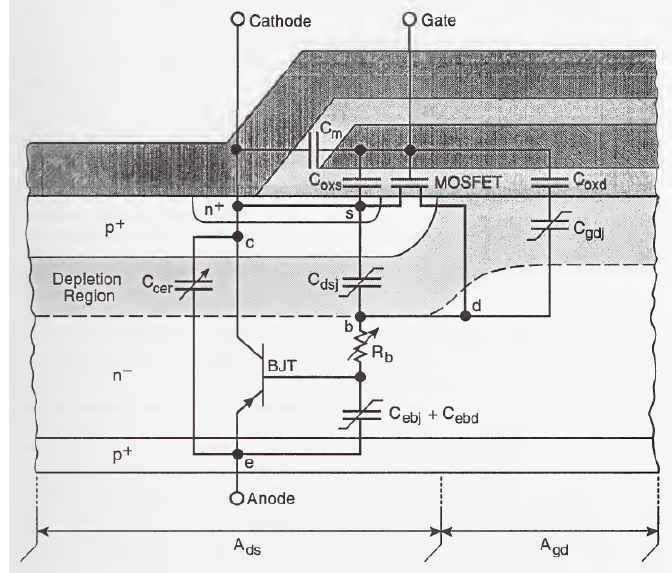
Figure 33. Example of a functional physics model for an IGBT with circuit elements superimposed (from